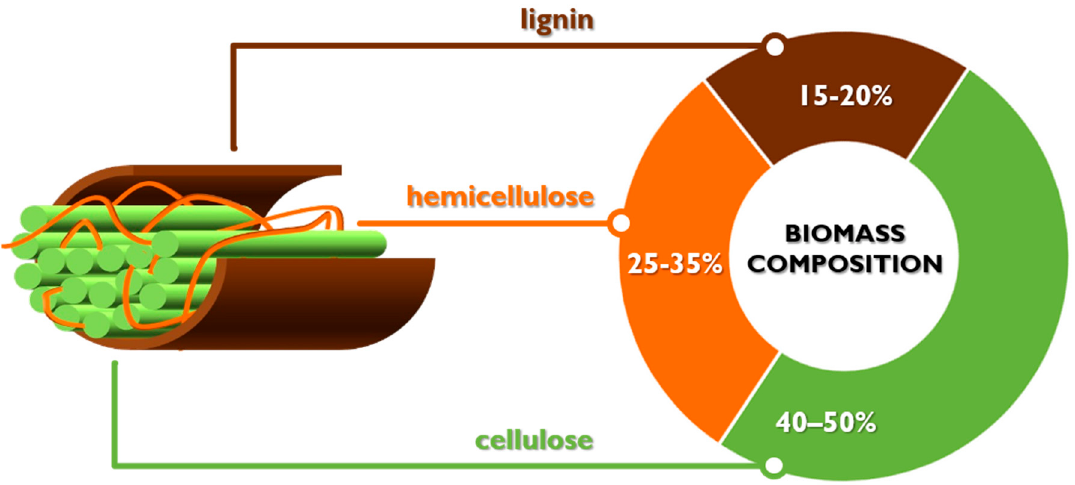
Figure 1. General composition of lignocellulosic biomasses.